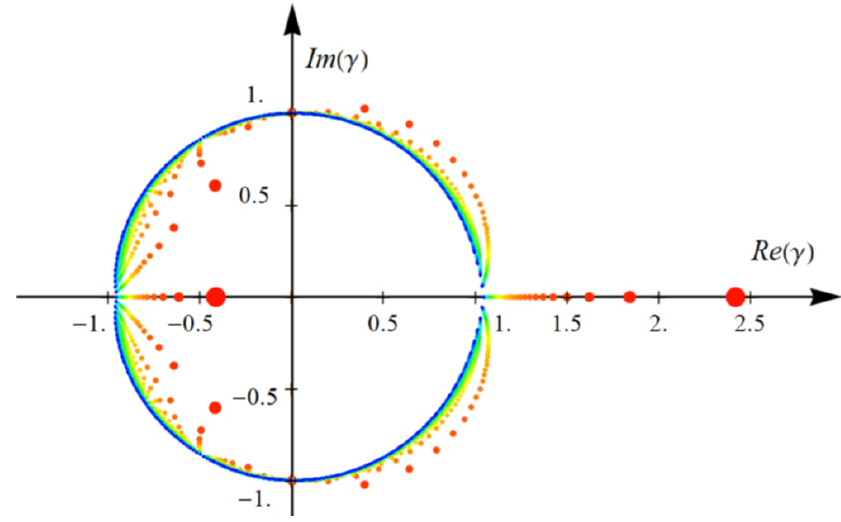
Figure 2. The graph of all roots γ of f k ( x ) = x k − x k − 1 − x − 1 for k ∈ [ 2,100 ] . We performed coloring points that correspond to the roots γ , in a manner that with increasing values of k decreased the size of the points, and their color changed gradually from warm colors to cold